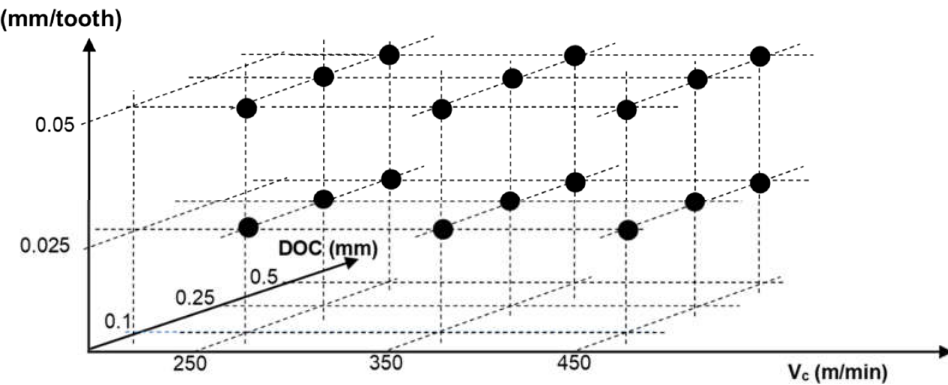
Figure 8. Design of experiments for a boring conventional measurement corresponding to Table 2 Group a of tool material characterization tests.